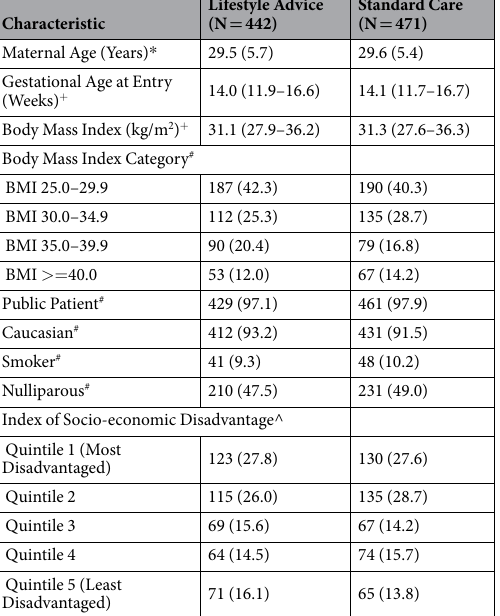
Table 1. Maternal baseline characteristics by randomised group. * Mean and standard deviation. + Median and interquartile range. # Number and %. ^Socioeconomic index as measured by SEIFA.